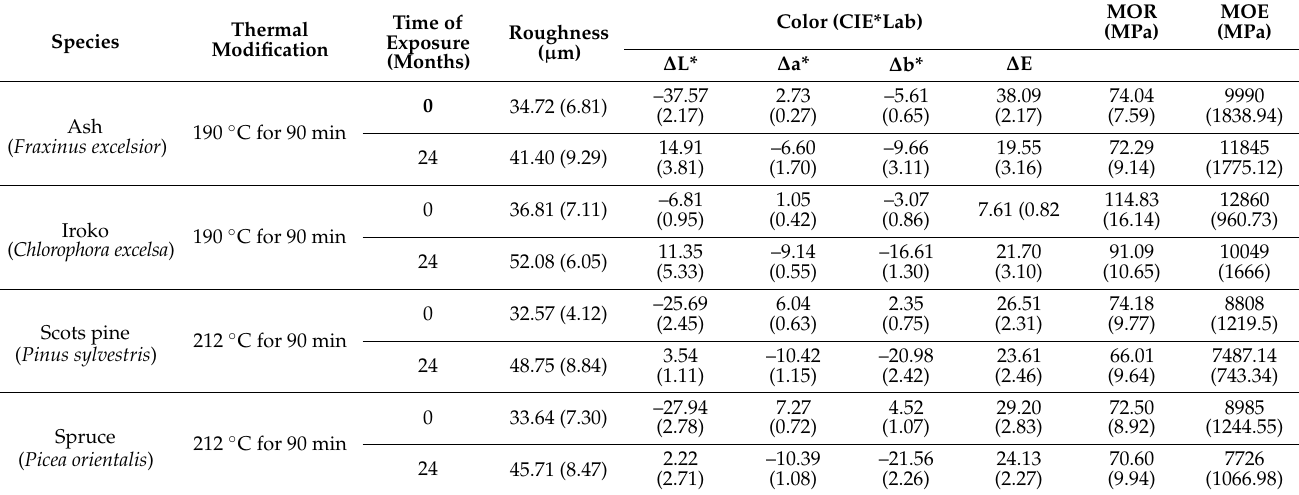
Table 4. Example of wood species surface and mechanical properties changes (adapted from Tomak et al. [33]). Thermal Species